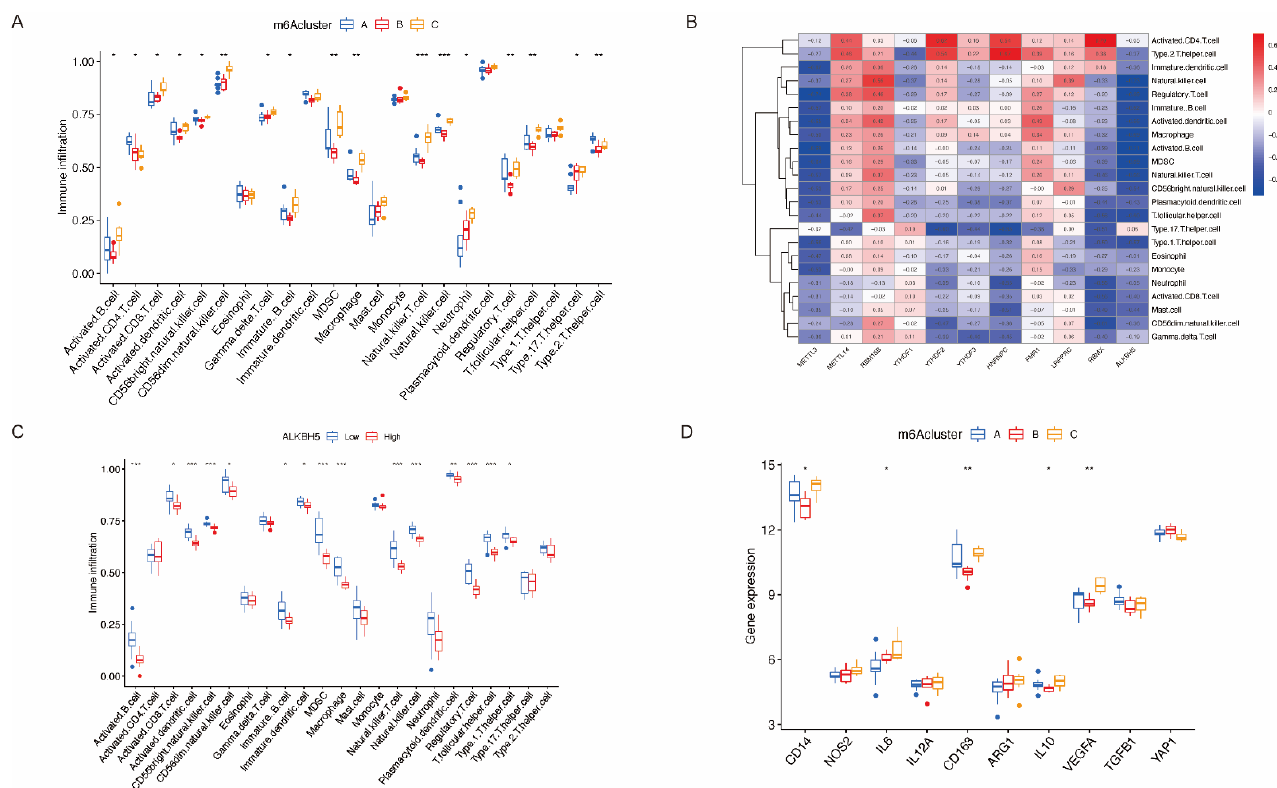
Figure 8. Analysis of genes related to immune infiltration and macrophage function. ( A ) The relationship between three subtypes and the infiltration of 23 immune cells. ( B ) Correlation between significant genes and 23 kinds of immune cells. ( C ) Variation and difference in the immune-cell infiltration between low and high ALKBH5 expression groups. ( D ) Analysis of macrophage-function-related genes in three subtypes. *: p < 0.05, **: p < 0.01, ***: p < 0.001.